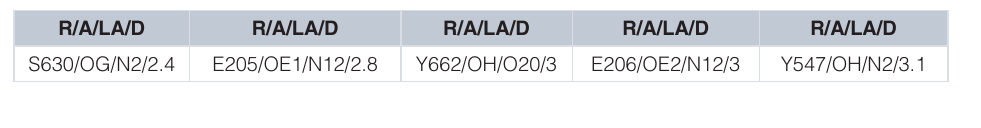
Table 1. Residues in dipeptidyl peptidase-IV (DPP4) holoenzyme (PDBid:3W2TA) that have non- hydrophobic interactions with the bound DPP4 inhibitor vildagliptin. Interactions are sorted based on the distance. R/A/LA/D: Residue number/Atom of the residue/Atom of ligand/distance between the interacting atoms (in Å). For example, ‘S630/OG/N2/2.4’ means that the atom OG from Ser630 is at 2.4 Å from the N2 atom of vildagliptin in PDBid:3W2TA.